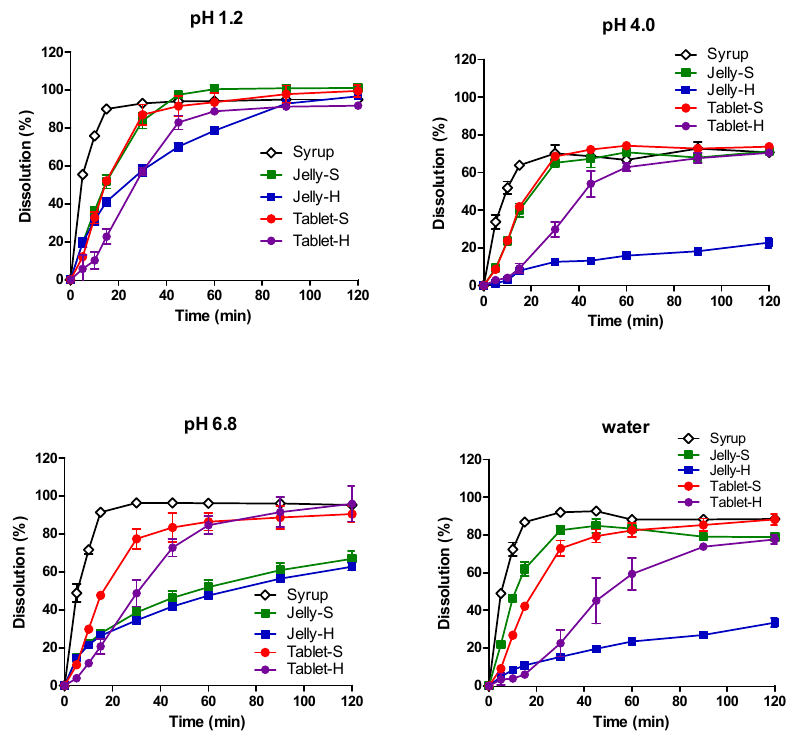
Figure 2. Dissolution profiles of chlorpheniramine maleate from various formulations in pH 1.2, 4.0, 6.8, and water at 37 °C. Each point represents mean ± standard deviation ( n = 6).